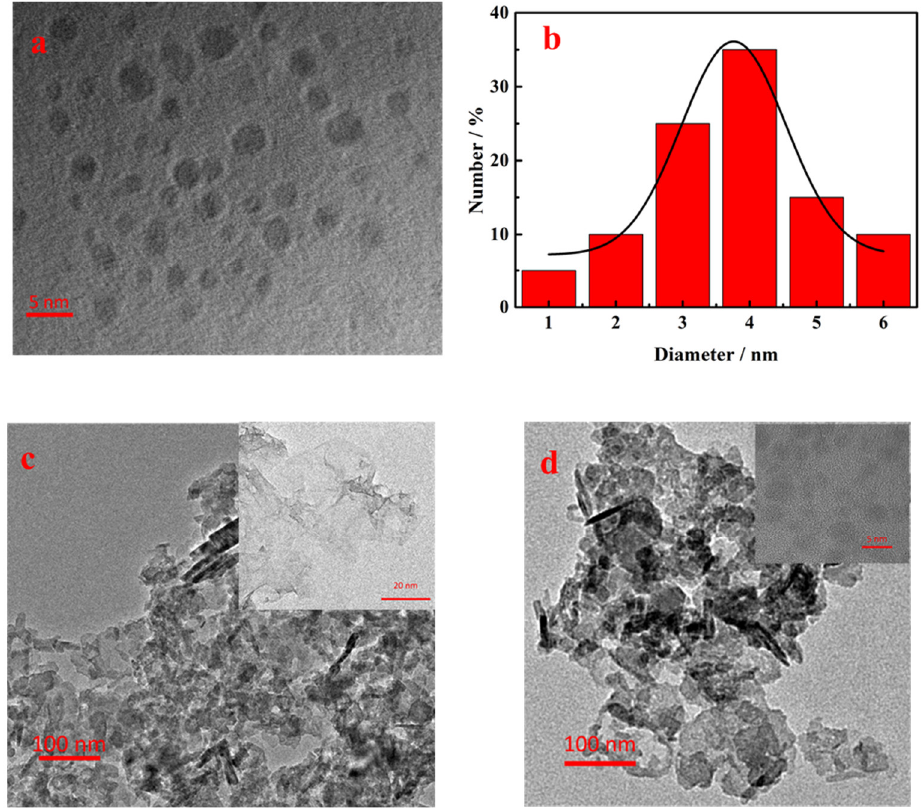
Figure 2. ( a ) HR-TEM images of SQDs; ( b ) the diameter distribution of the SQDs; ( c ) TEM images of MnO 2 NS with HR-TEM images of MnO 2 NS (inset); ( d ) TEM images of SQDs@MnO 2 NS with HR-TEM images of SQDs@MnO 2 NS (inset).